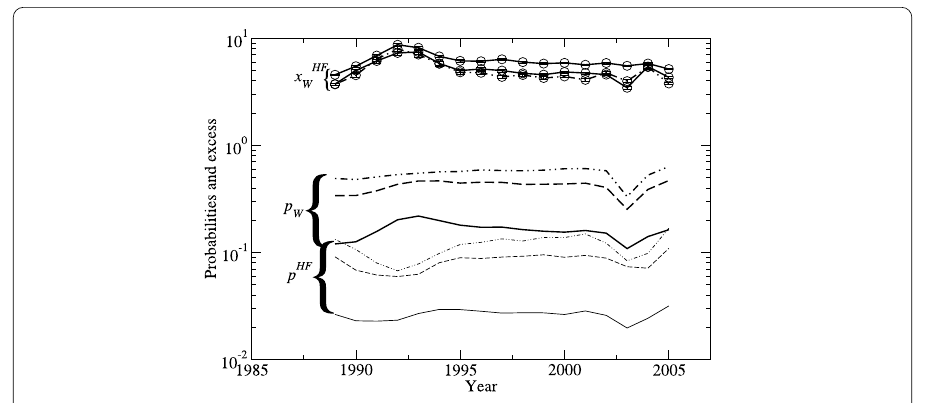
Figure 4 The densities ℘ ( HF ) ( t , (cid:2) t ), ℘ W ( t , (cid:2) t ) and the excess probability x ( HF ) W ( t , (cid:2) t ), where (cid:2) t = 2 with the following symbol code: (—) lines represent W = 1, (– · · –) lines represent W = 2, (– – –) lines represent W = 3; thin lines represent ℘ ( HF ) ( t , (cid:2) t ), thick lines represent ℘ W ( t , (cid:2) t ), and thick lines with ◦ represent x ( HF ) W ( t , (cid:2) t ). The brackets signal the location of ℘ ( t , (cid:2) t ), ℘ W ( t , (cid:2) t ), and x ( HF ) W ( t , (cid:2) t ) in the plot. The plot